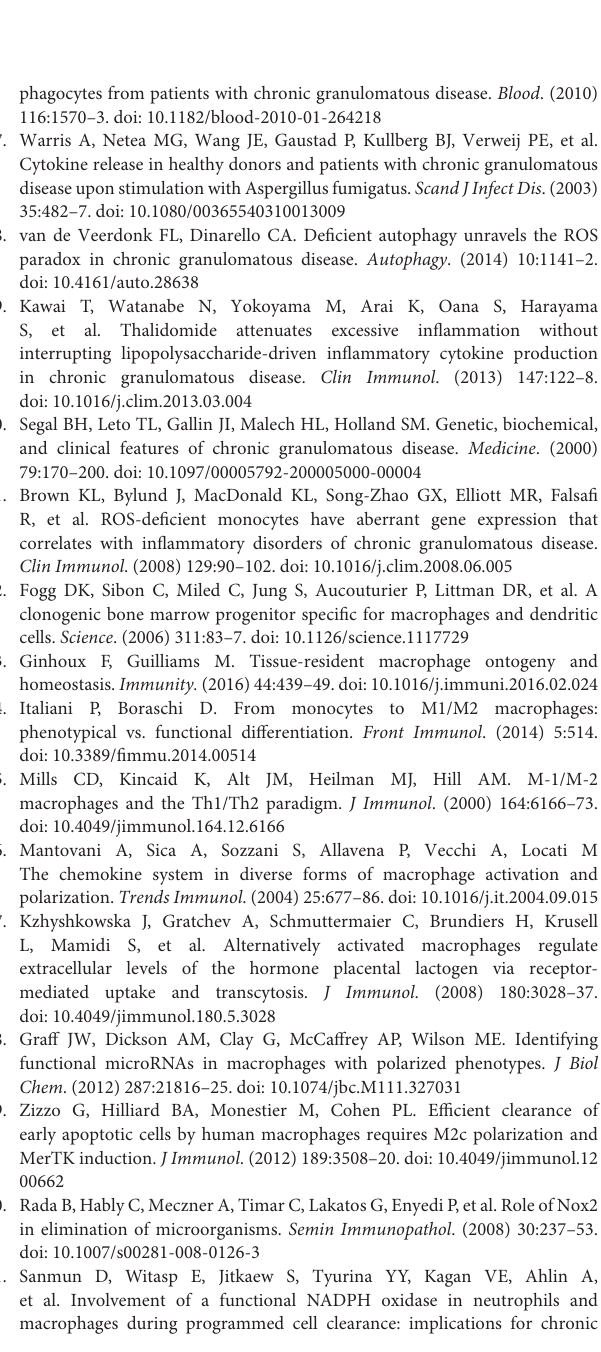
Table S1 | Cellular composition of analyzed primary derived CGD patient tissue